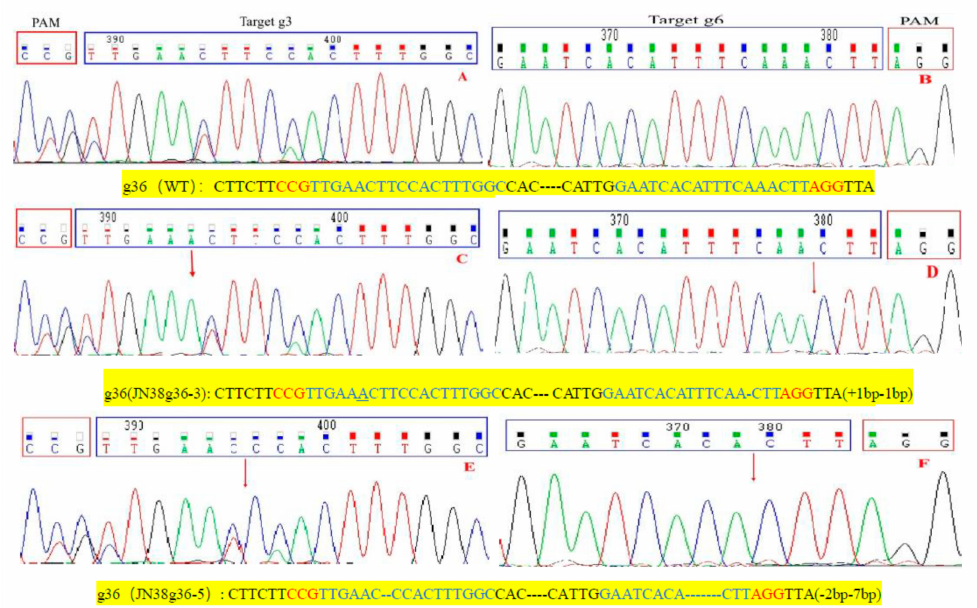
Figure 3. Analyses of sequencing chromatogram data of the target mutant sites of g36. ( A – F ) are sequence peaks of wild type and representative mutation types at target site g36 respectively. The red arrowheads indicate the location of mutations.